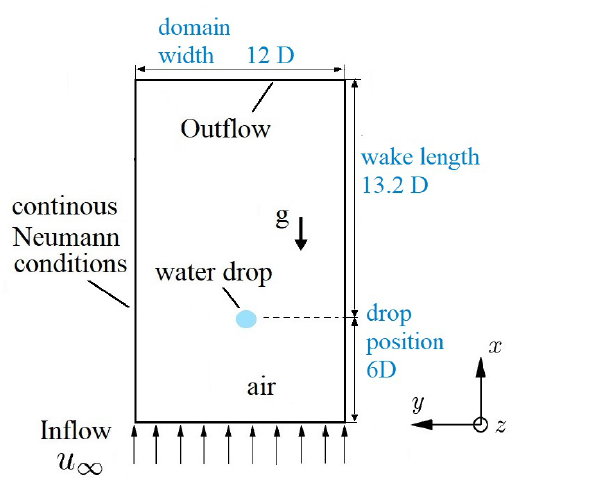
Figure 3. Computational domain for the fall of a water drop in air flow, displayed in a 2D slice.